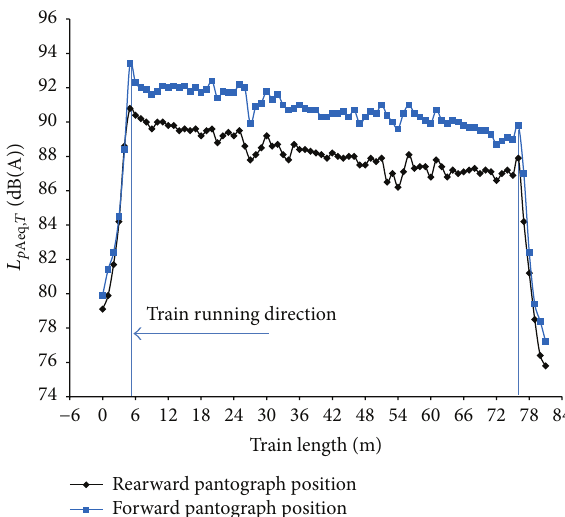
Figure 25: Comparison of the longitudinal SPL distributions for different pantograph fairing installation positions.